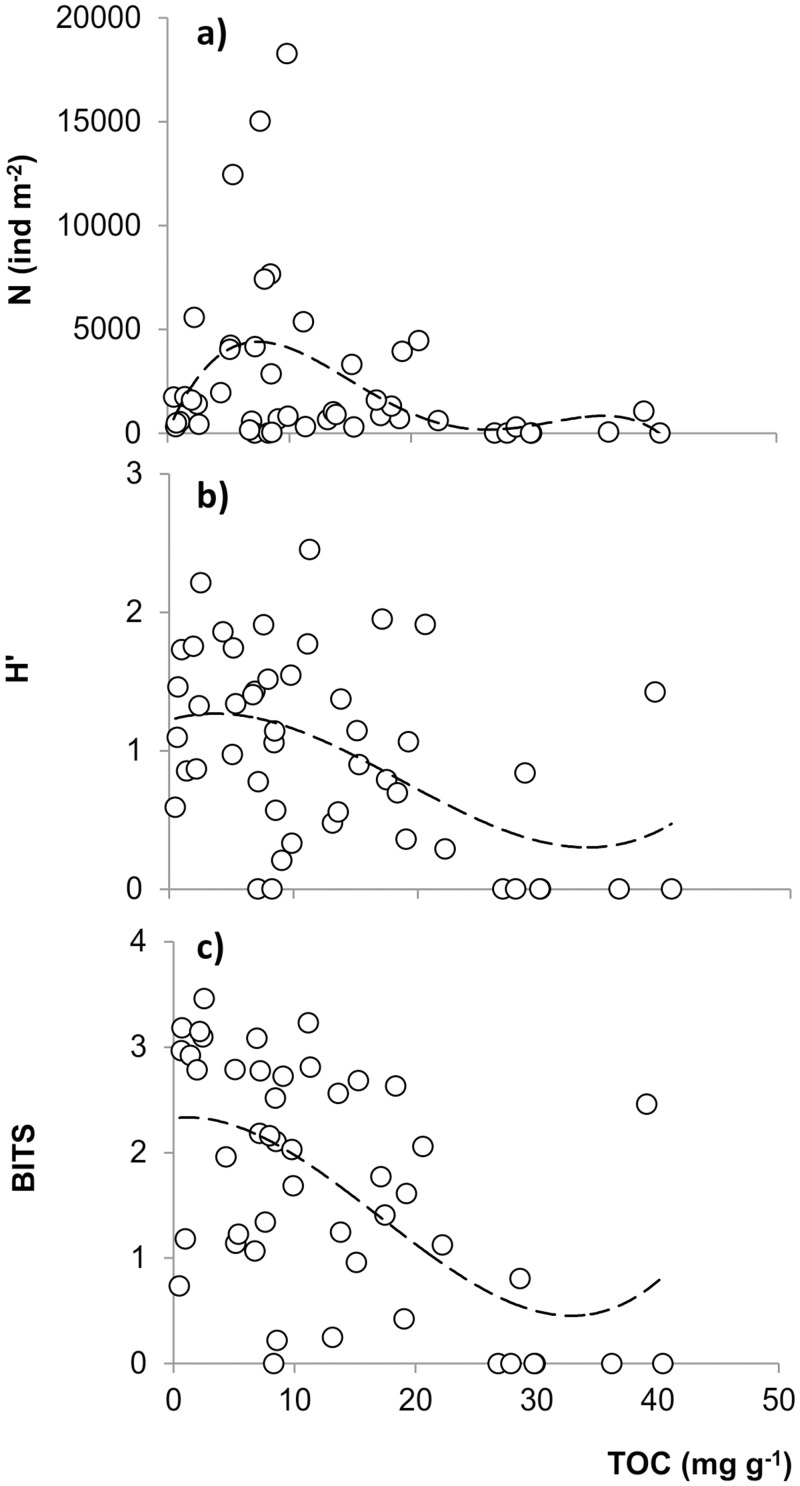
Distribution of various measures of benthic macrofaunal response along a TOC gradient: (a) Total abundance N; (b) Shannon diversity H’; (c) BITS.All correlations were described by polynomial functions. N-TOC: y = -0.0498x4 + 4.6137x3 - 139.65x2 + 1392.5x + 26.339 R = 0.41. H’-TOC: y = 7E-05x3 - 0.004x2 + 0.0269x + 1.2213; R = 0.47. BITS-TOC: y = 0.0001x3 - 0.006x2 + 0.0137x + 2.3257; R = 0.57.